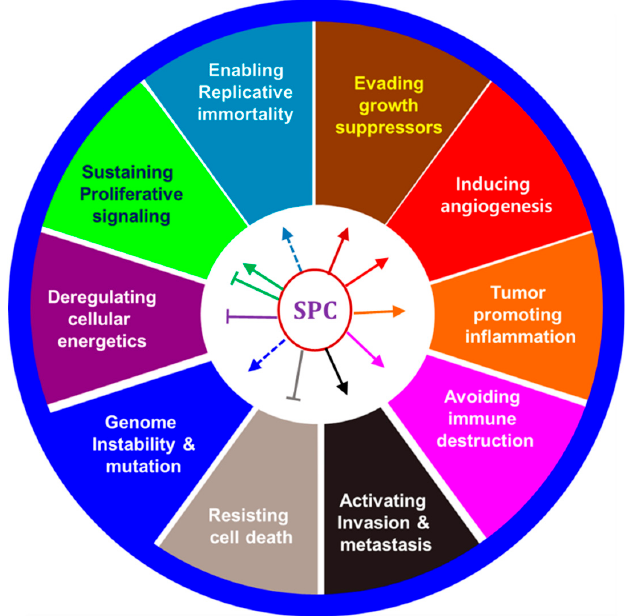
Figure 2. Effects of SPC on hallmarks of cancer. Figure 2. E ff ects of SPC on hallmarks of